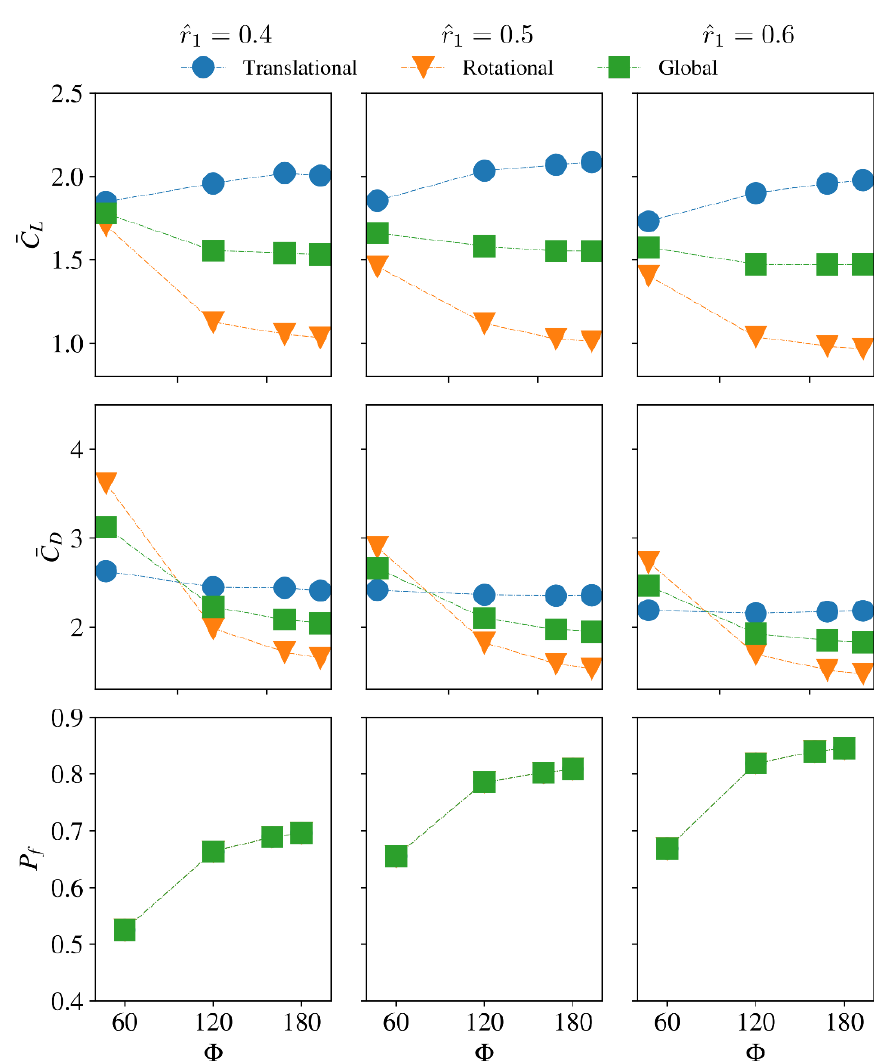
Figure 14. Comparison of the average lift and drag coefficients as well as power factor for different stroke amplitudes and radial centroid locations. Aspect ratio is fixed at 4.5.